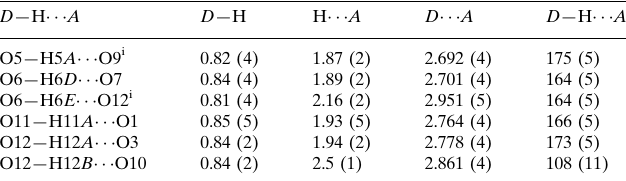
Hydrogen-bond geometry (A˚ , (cid:2)